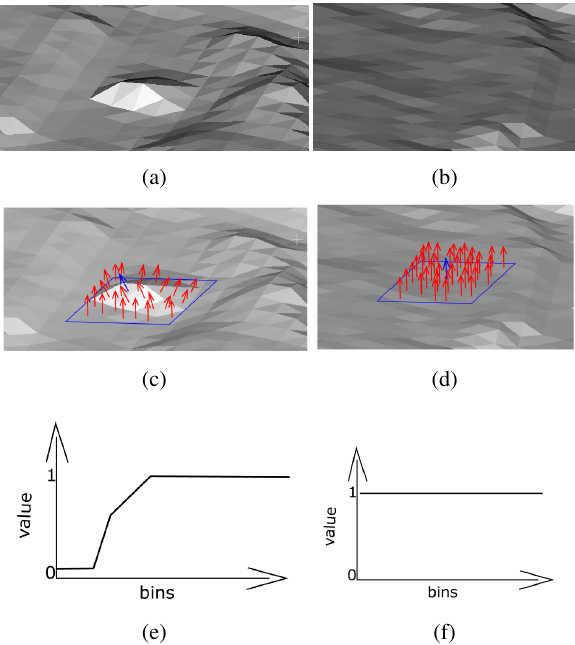
Figure 3. Principle of the key plane descriptor in comparison of a cone like area (a,c,e) and a plane like area (b,d,f), top (a,b): the area itself, middle (c,d): shematic drawing descriptor mask (blue) with the center normal (blue) and the neighbour normals (red), bottom (e,f): the histogram of angles with normed relative